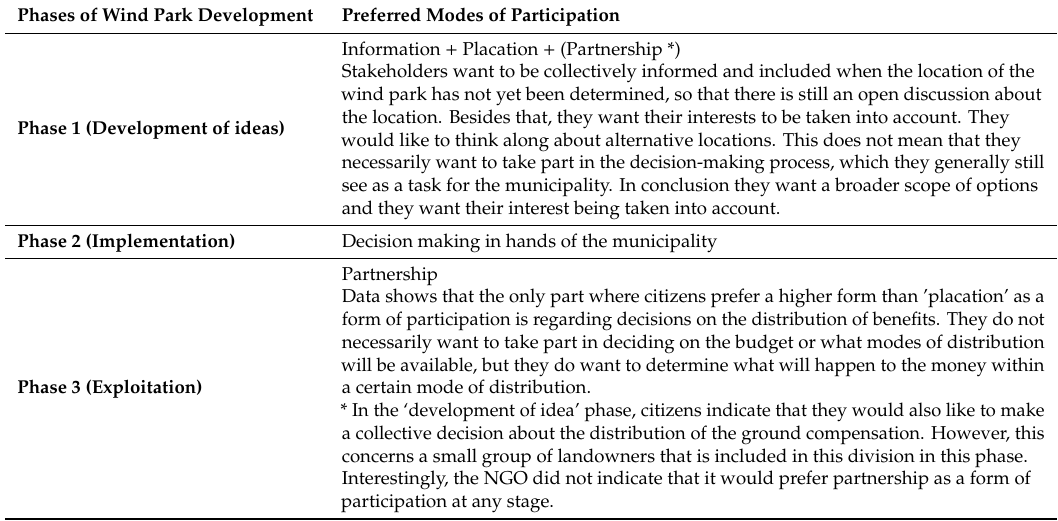
Table 6. Preferred modes of participation per phase in wind park development in